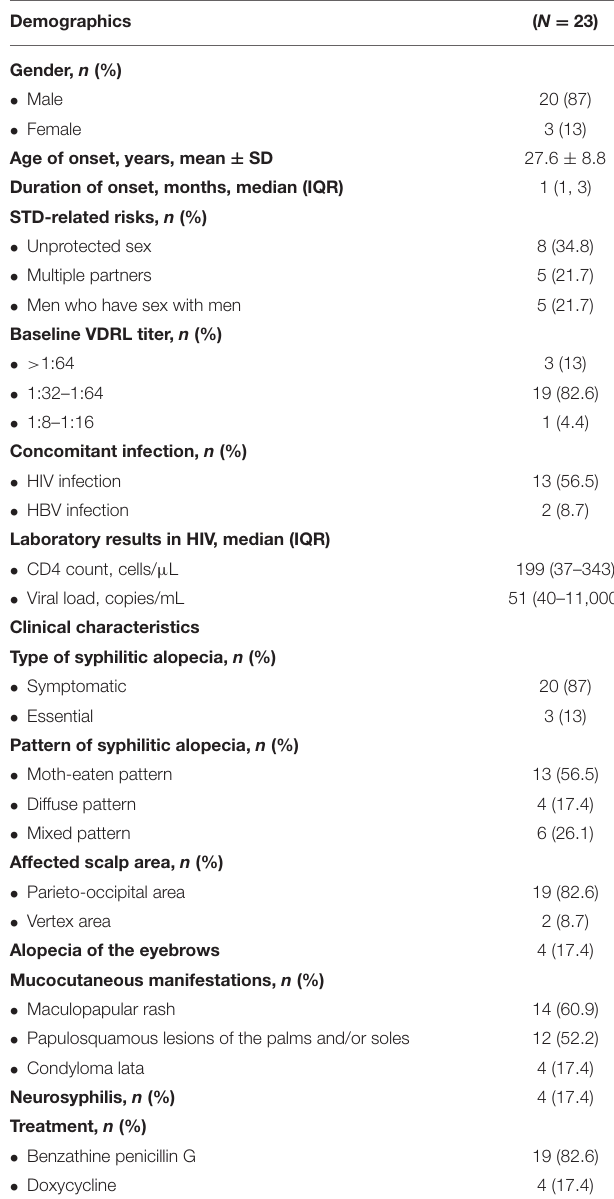
TABLE 1 | Dermographics, clinical characteristics, laboratory results, and treatment of Thai patients with syphilitic alopecia.